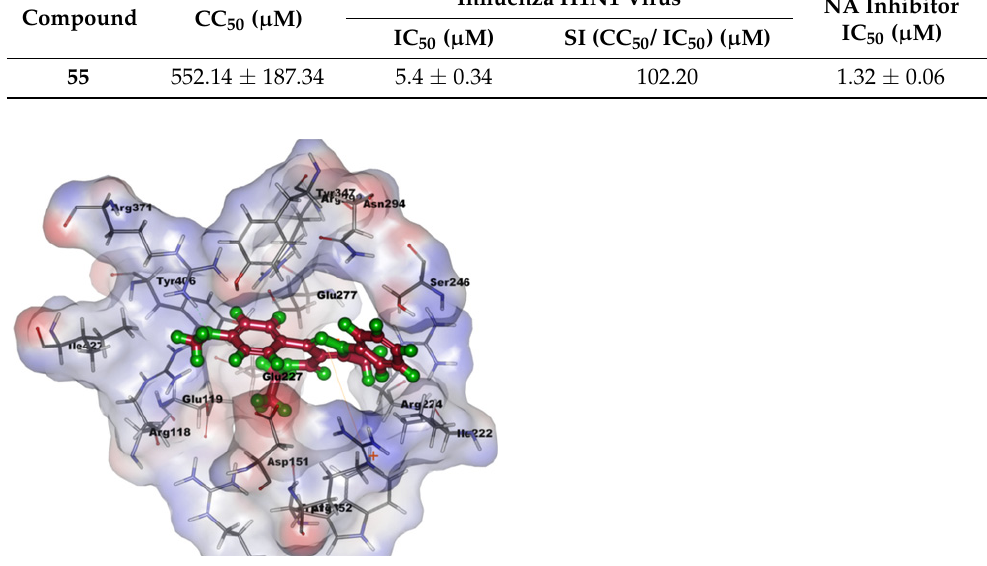
Figure 13. Molecular interaction of compound 55 in the binding site of H1N1 neuraminidase [52]. Table 7. The inhibitory activity of compound 55 against influenza H1N1 virus and neuraminidase. Compound